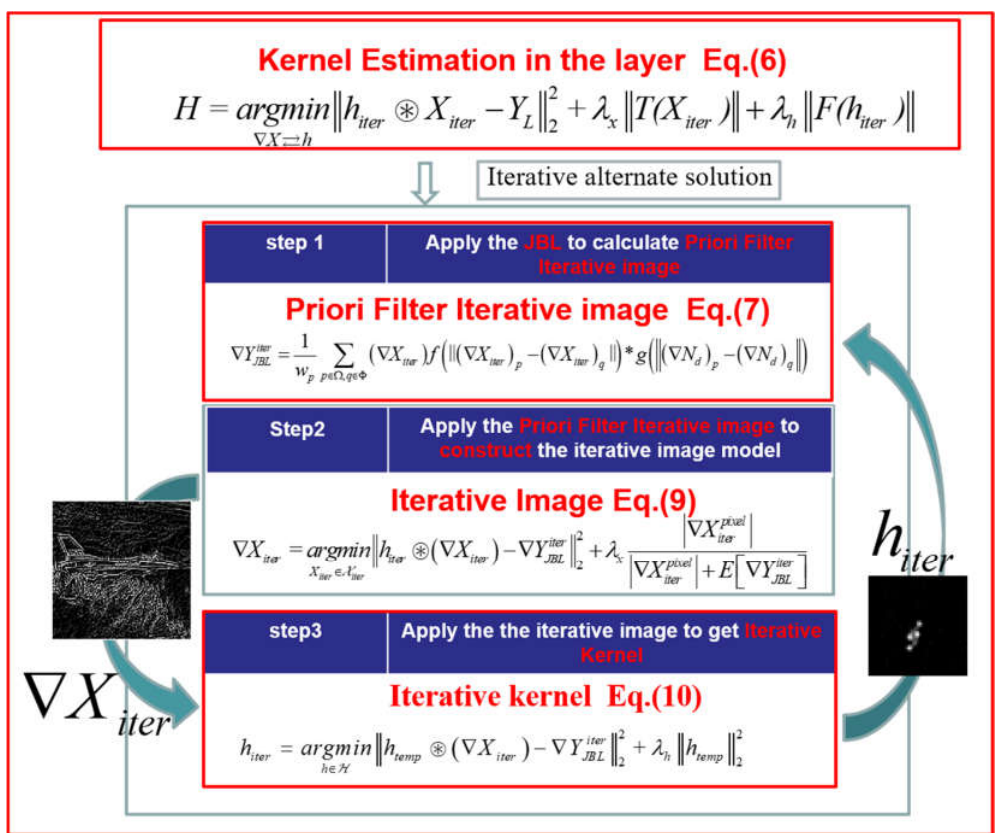
Figure 2. Flow chart of the kernel estimation model in the example layer. Step 1. Apply a joint bilateral filter (JBF) [23] algorithm to update the example layer’s priori filter image (Section